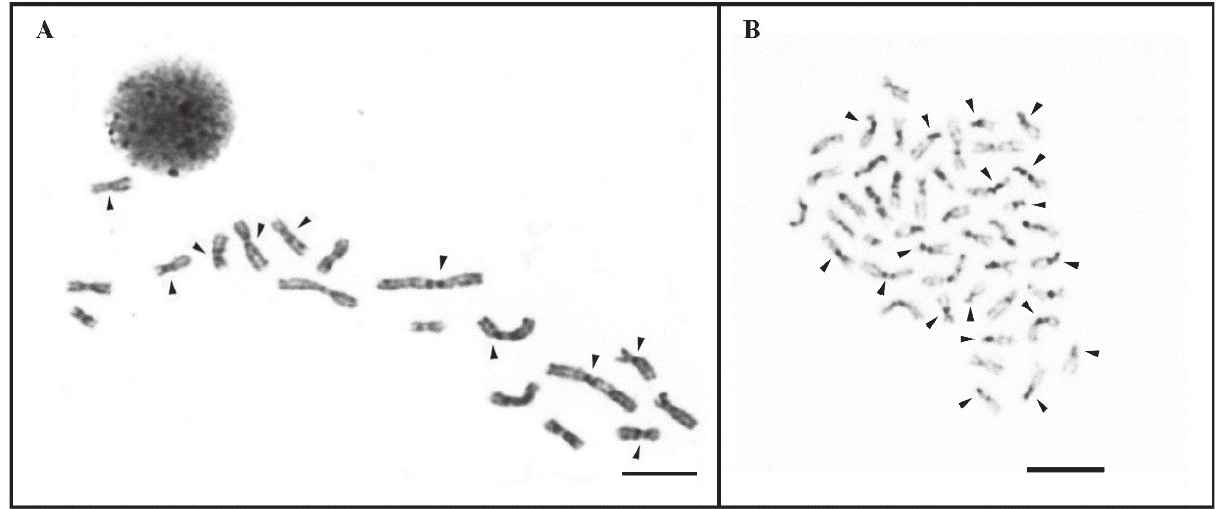
Figure 2. Metaphases showing heterochromatic blocks (arrowheads) via 4% Giemsa staining in (A) Dolichoderus bidens (2n = 18) on cen- tromeric and pericentromeric regions and (B) Gnamptogenys tortuolosa (2n = 44) on pericentromeric regions of all chromosomes and short arms of subtelocentric pairs. Scale bar = 5